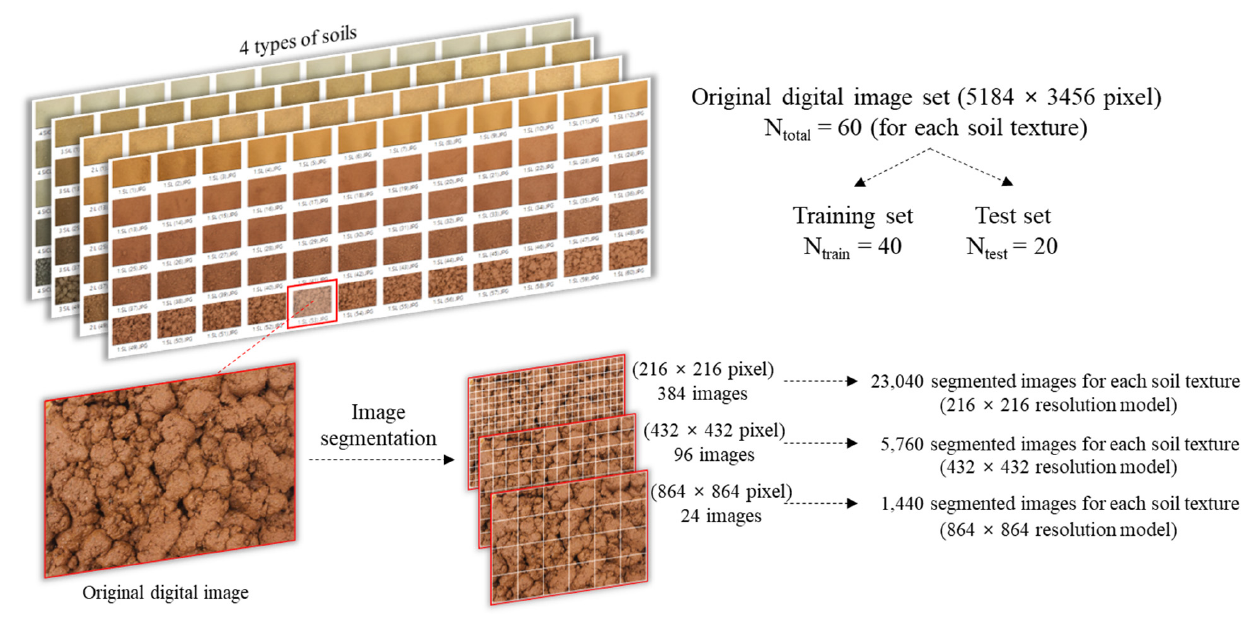
Figure 2. Training and test data preparation process for the convolutional neural network model.